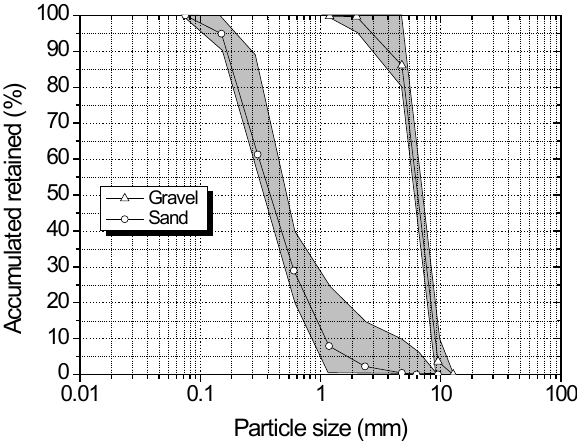
Figure 1 – Grading curve of aggregates.